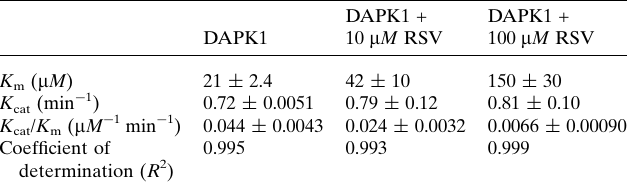
Table 2 X-ray diffraction data-collection and refinement statistics. DAPK1–RSV DAPK1–PIC